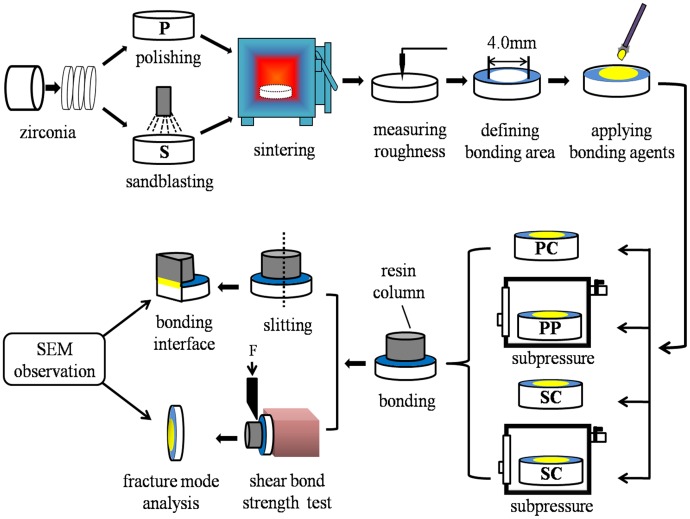
The flow chart of the experiment.